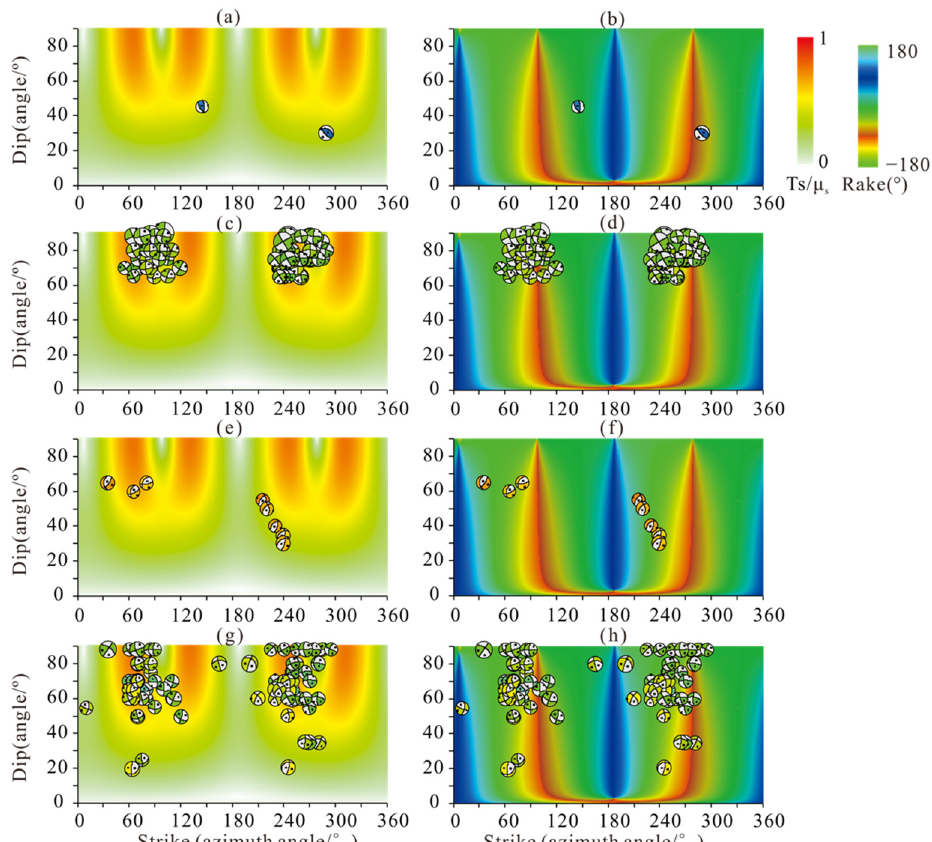
Figure 6. Distribution characteristics of fault slip tendency with strike and dip angles in the Yingjiang area. ( a , c , e , g ) Slip tendency (Ts/ µ s ) normalized by the frictional coefficient and ( b , d , f , h ) distribution of rake angles. ( a , b ) Distribution of historical reverse faulting earthquakes; ( c , d ) distribution of strike–slip historical earthquakes; ( e , f ) distribution of normal faulting historical earthquakes; and ( g , h ) distribution of oblique historical earthquakes.